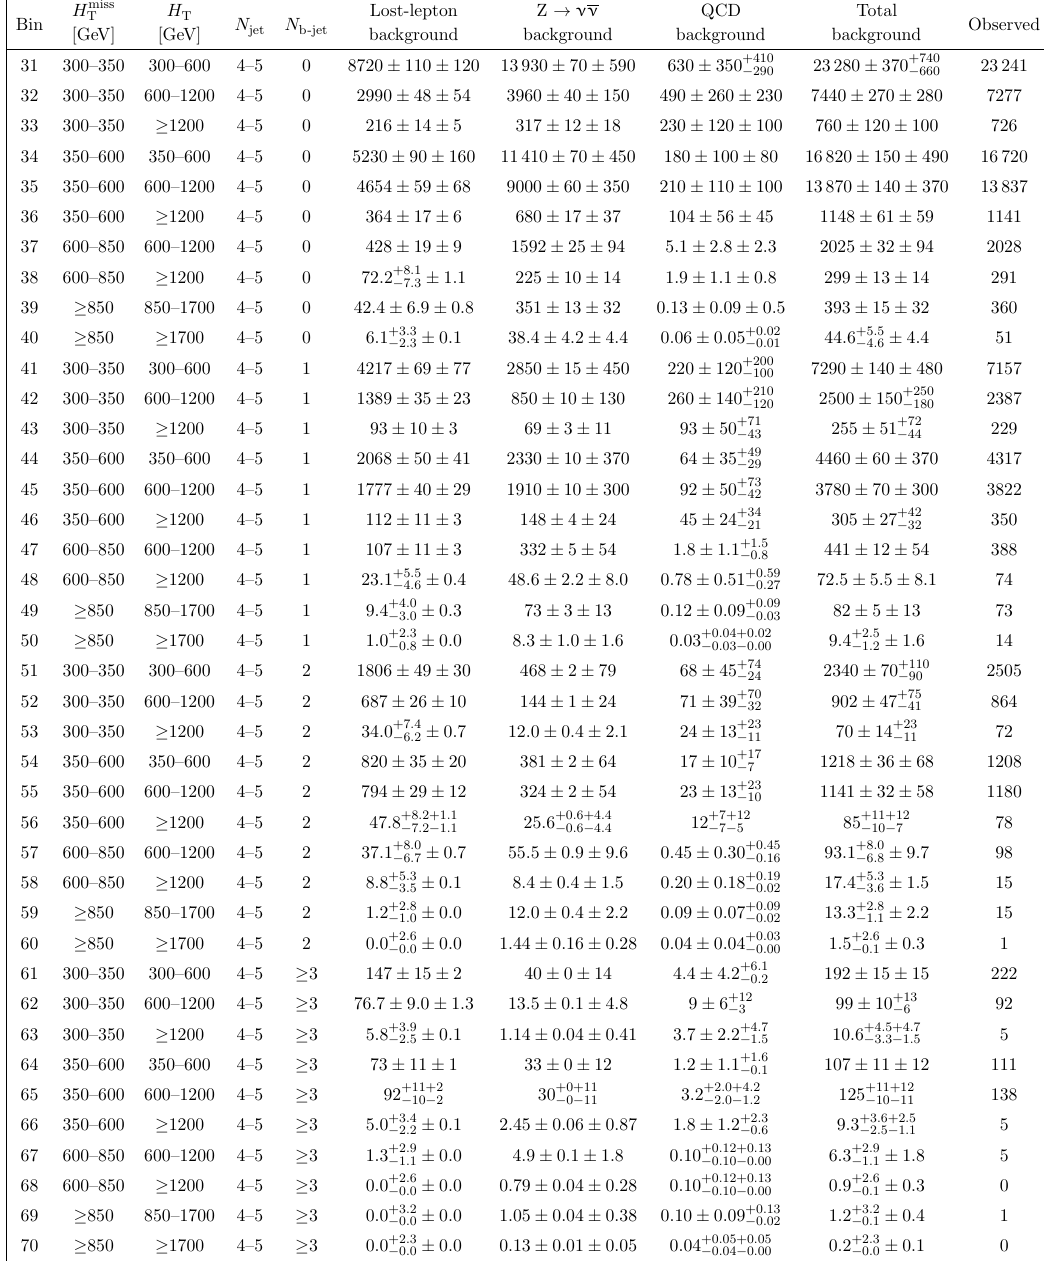
Table 4 . Observed number of events and pre-(cid:12)t background predictions in the 4 (cid:20) N bins. For the background predictions, the (cid:12)rst uncertainty is statistical and the second